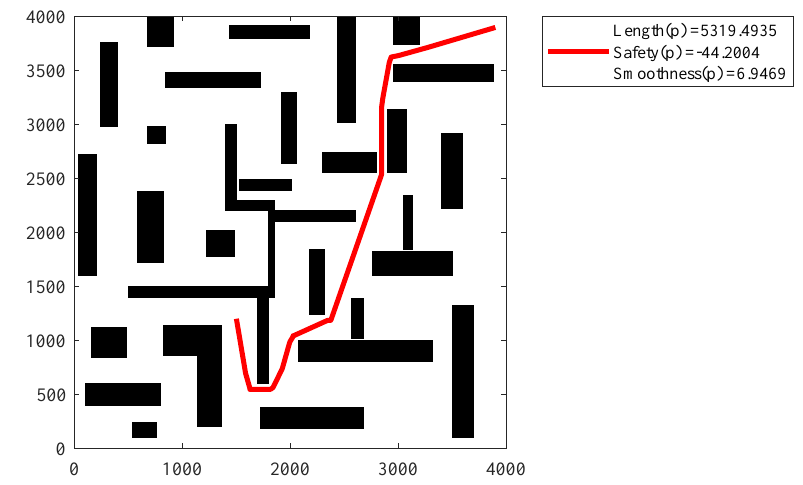
Figure 14. Graphical solution for the Figure 8A with